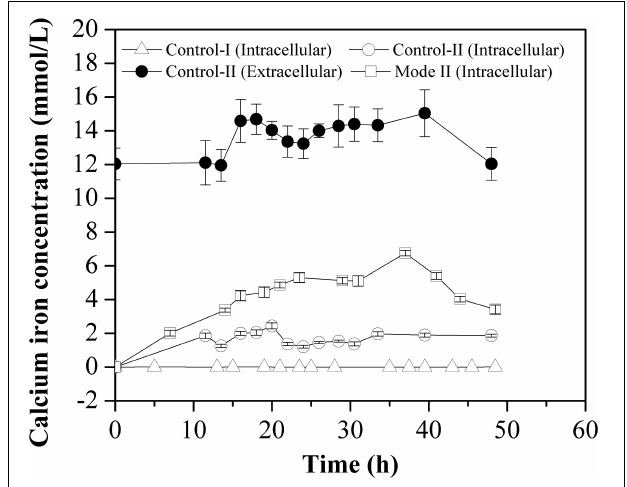
FIGURE 4 | Free Ca 2 + concentration inside the cells grown in different batch cultures. The intracellular Ca 2 + concentration was measured in crude cell extracts and all measurements were performed in